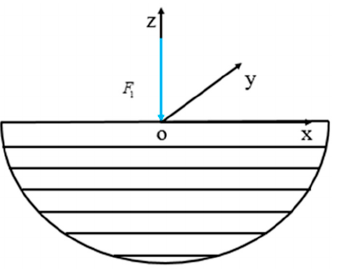
where 1 E and 2 E are the elastic moduli of the parallel transversely isotropic plane (XOY Figure 2. A transversely isotropic elastic half-plane surface subjected to vertically concentrated Figure 2. A transversely isotropic elastic half ‐ plane surface subjected to vertically concentrated plane) and the vertical transversely isotropic plane (z ‐ axis direction), respectively; 1  stress. and 2  are Poisson’s ratios characterizing the lateral strain response in the plane of transverse isotropy to a stress acting parallel or normal to it, respectively; and 2 G is the shear modulus in the vertical isotropic plane.